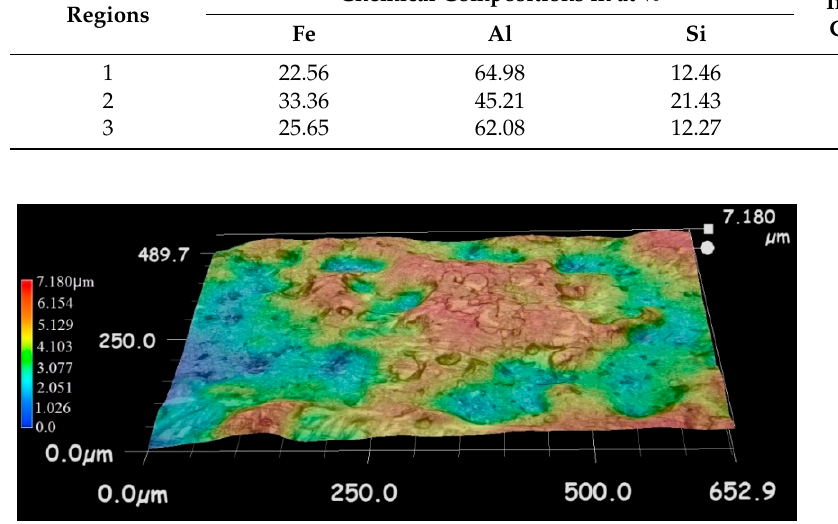
Figure 1. Cross sectional characterization of Al–Si coating boron steel sheet of ( a ) Hot-dipped coating and ( b ) details of intermetallic compound layer. Table 2. EDS results of marked regions in the Al–Si coating under hot-dipped conditions. Regions